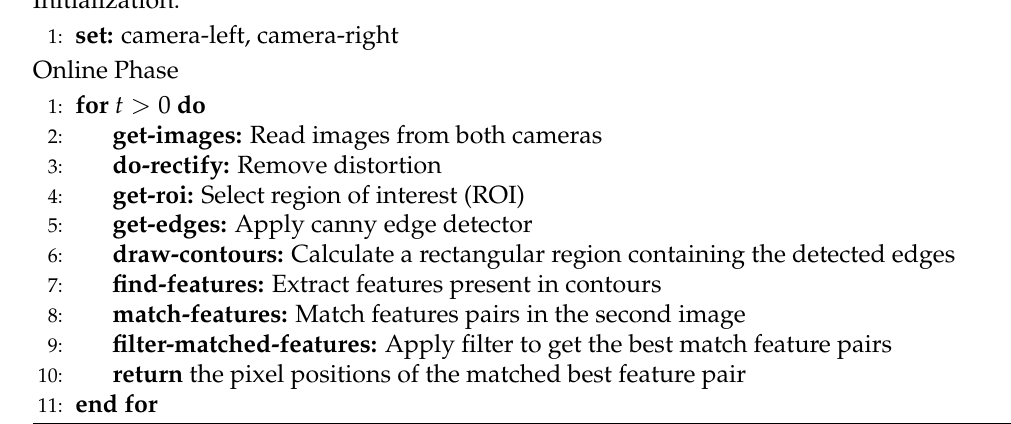
Algorithm 1 Stereo vision-based positioning